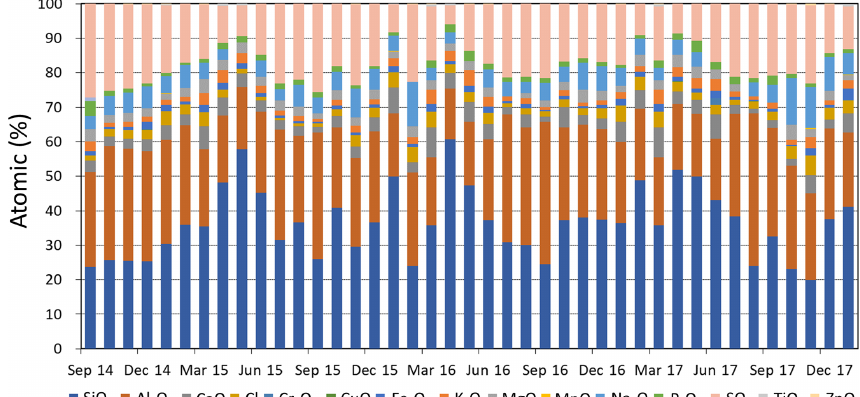
Figure 6. Temporal variations in the chemical composition of PM f as measured by XRF.